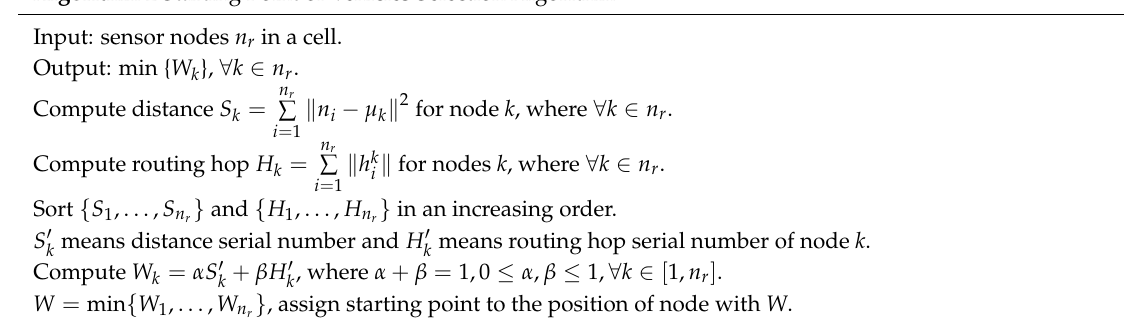
Algorithm 2 Starting Point of Vehicles Selection